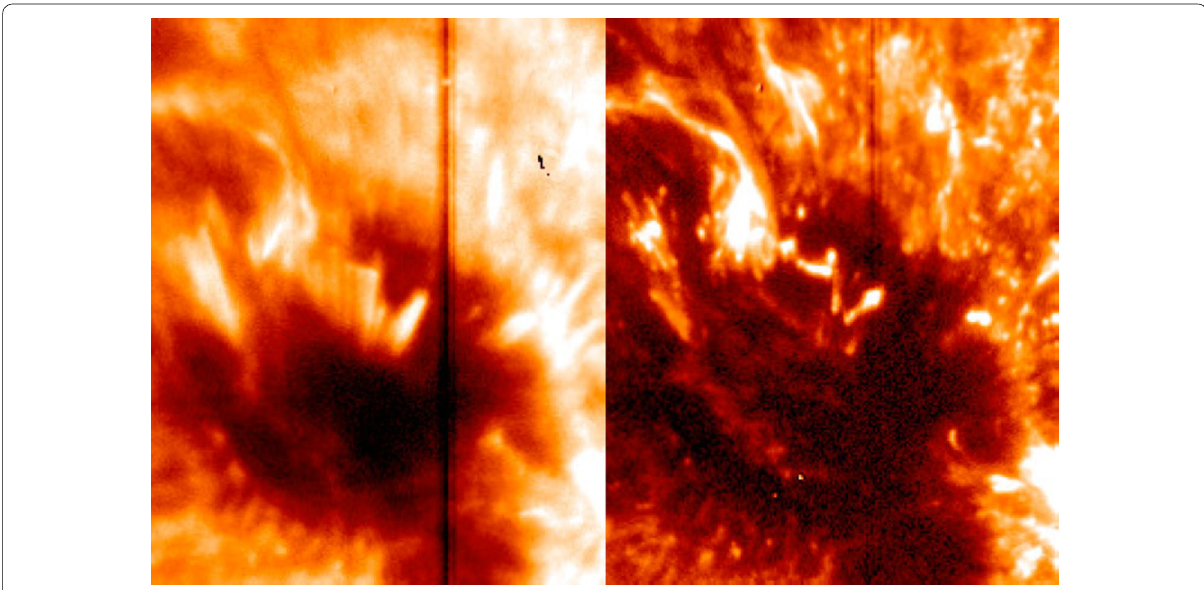
Fig. 3 Images of the chromosphere (left, IRIS SJI 2796 Å) and TR (right, IRIS SJI 1400 Å) in a sunspot region. These images were taken on July 20, 2013. The field of view of each image has a size of 34 ″ 42 ″ . Image reproduced with permission from Zhang et al. (2017), copyright by ×